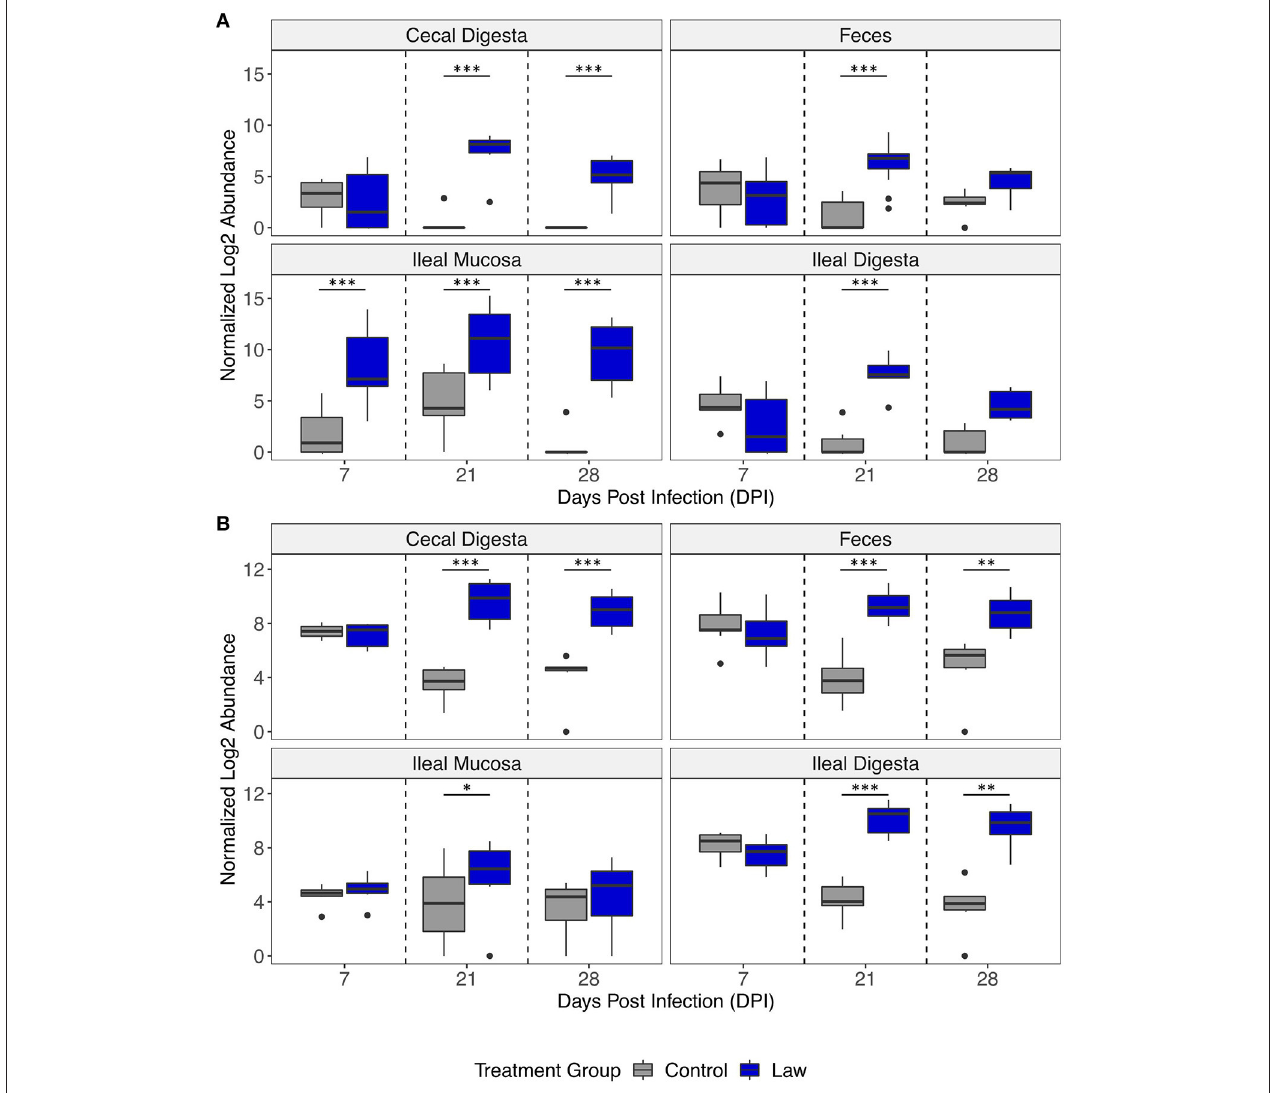
FIGURE 5 | Differential abundances of the genera (A) Chlamydia and (B) Collinsella between Law and Control treatment groups in different intestinal segments over days post-infection. Asterisks indicate significant differences between treatment groups. * p < 0.05; ** p < 0.01; and *** p < 0.001.